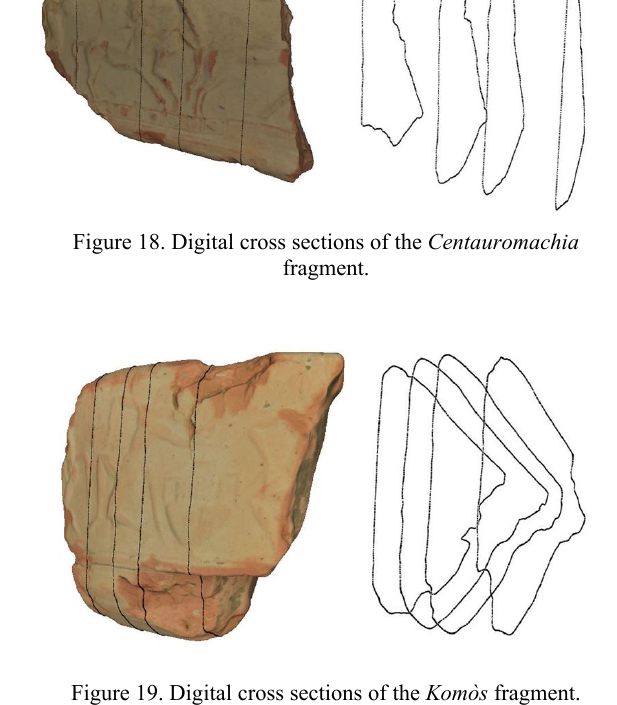
Figure 13. 3D model of the fragment with Centauromachia scene.